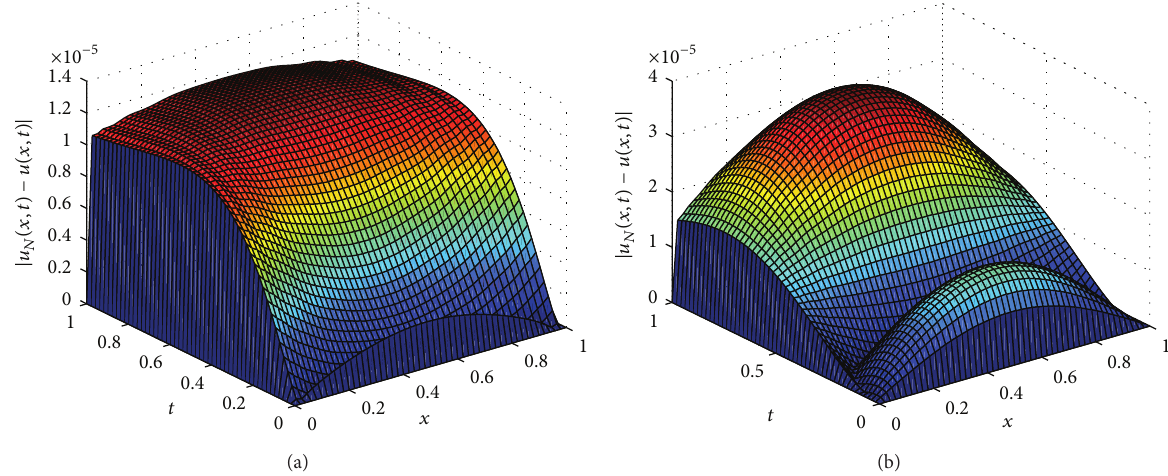
Figure 3: Plot of the absolute errors with 𝛼 = 1.3 (a) and 𝛼 = 1.7 (b).